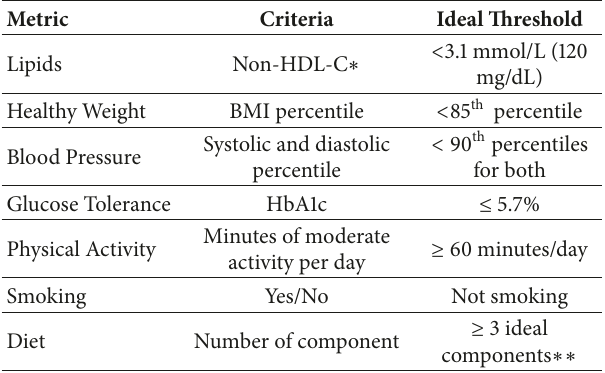
Table 1: Seven cardiovascular health metrics, modified for point-of- care